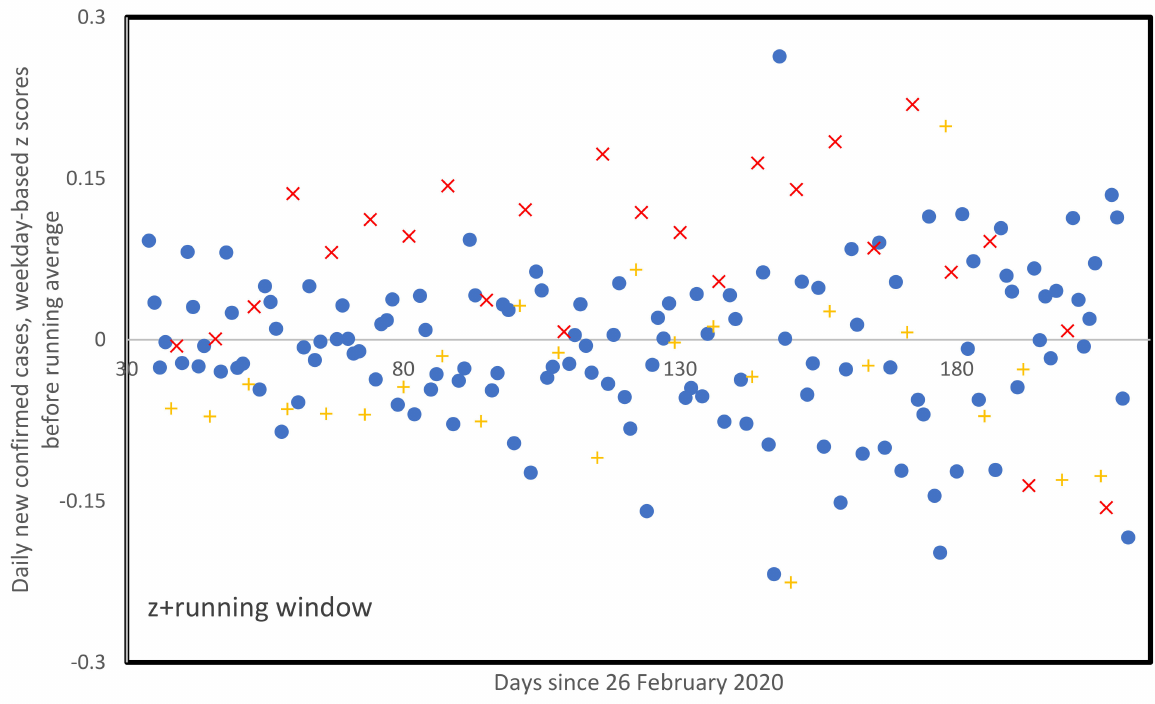
Figure 10. Smoothed confirmed world daily new cases [30] applied to z-scores from Figure 8, as a function of days since 26 February 2020 until 23 August 2020 + indicates Sundays, X indicates Mondays. Z-transformations are specific to each weekday. For specific day j, the mean number of confirmed new cases calculated for days j − 1, j − 2, j, j + 1, j + 2 is subtracted from the number for day